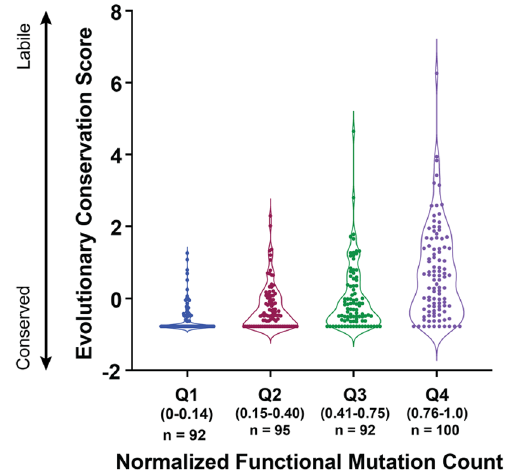
Figure 7. Site susceptibility to accepting missense mutations correlates with evolutionary conservation. The normalized functional mutation count (defined as the number of enriched/functional mutations divided